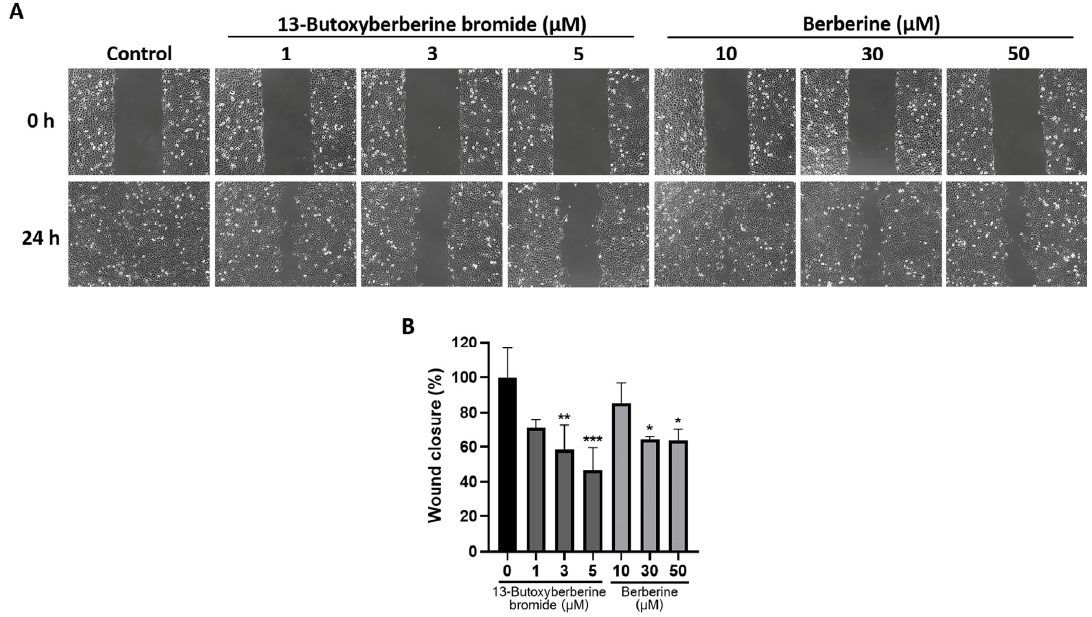
Figure 2. Inhibitory effect of 13-butoxyberberine bromide and berberine on wound healing in A431 cells. Cells were scratched and incubated with different concentrations of 13-butoxyberberine bromide and berberine before investigating the wound areas. ( A ) Wound distance was observed under an inverted microscope (100 × magnification). ( B ) The histogram presents the wound closure percentage after incubation with 13-butoxyberberine bromide and berberine. Data were expressed as mean ± SD ( n = 3). * p < 0.05, ** p < 0.01 and *** p < 0.001; significant difference from the control group.